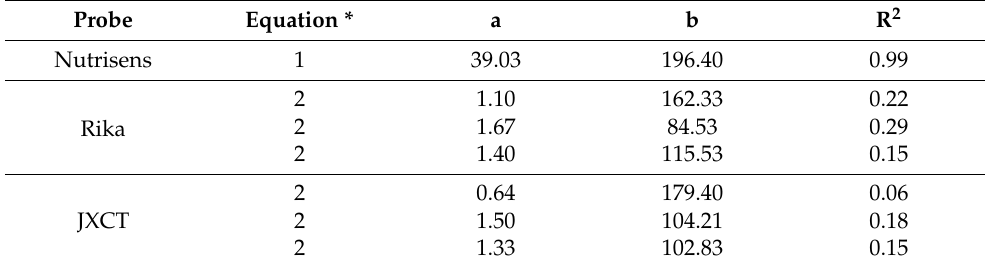
Table 2. Fitting and determination coefficients for the probes when increasing the EC in absence of nitrate concentration.